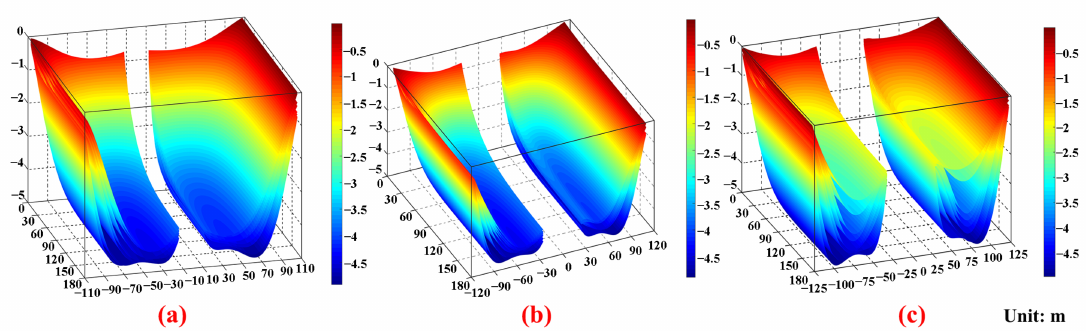
Figure 13. 3D subsidence value cloud map of overlying strata in GAWF. ( a ) GFST, ( b ) GFMT, and ( c )